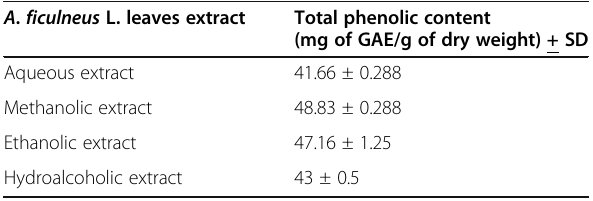
Table 5 Total phenolic content in different A . ficulneus L. leaves extracts of Gallic